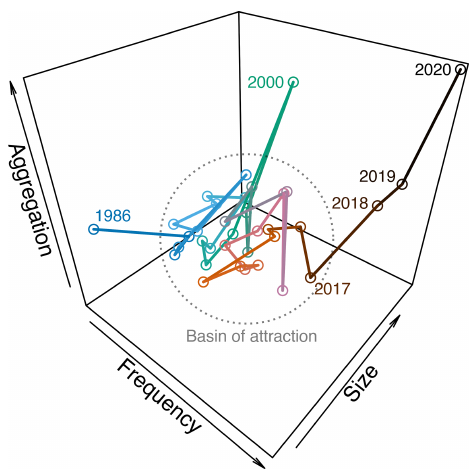
Figure 3. Forest disturbance anomalies at the regional level in refer- ence to 1986–2015, with the years 2018–2020 highlighted. Anoma- lies are expressed in percent area change; that is + 100% indicates a doubling of disturbed forest area relative to the average forest area disturbed in the period 1986–2015. Abbreviations for the regions are C (central Europe), E (eastern Europe), N (northern Europe), S- E (southeastern Europe), S-W (southwestern Europe), and W (west- ern Europe). See Table S1 for details at the country level.